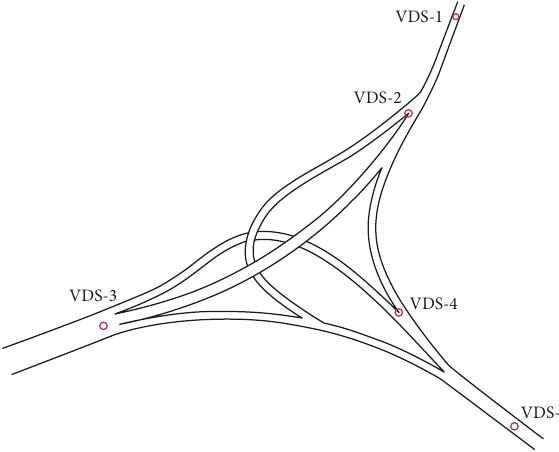
Figure 4: Locations of the five VDS.